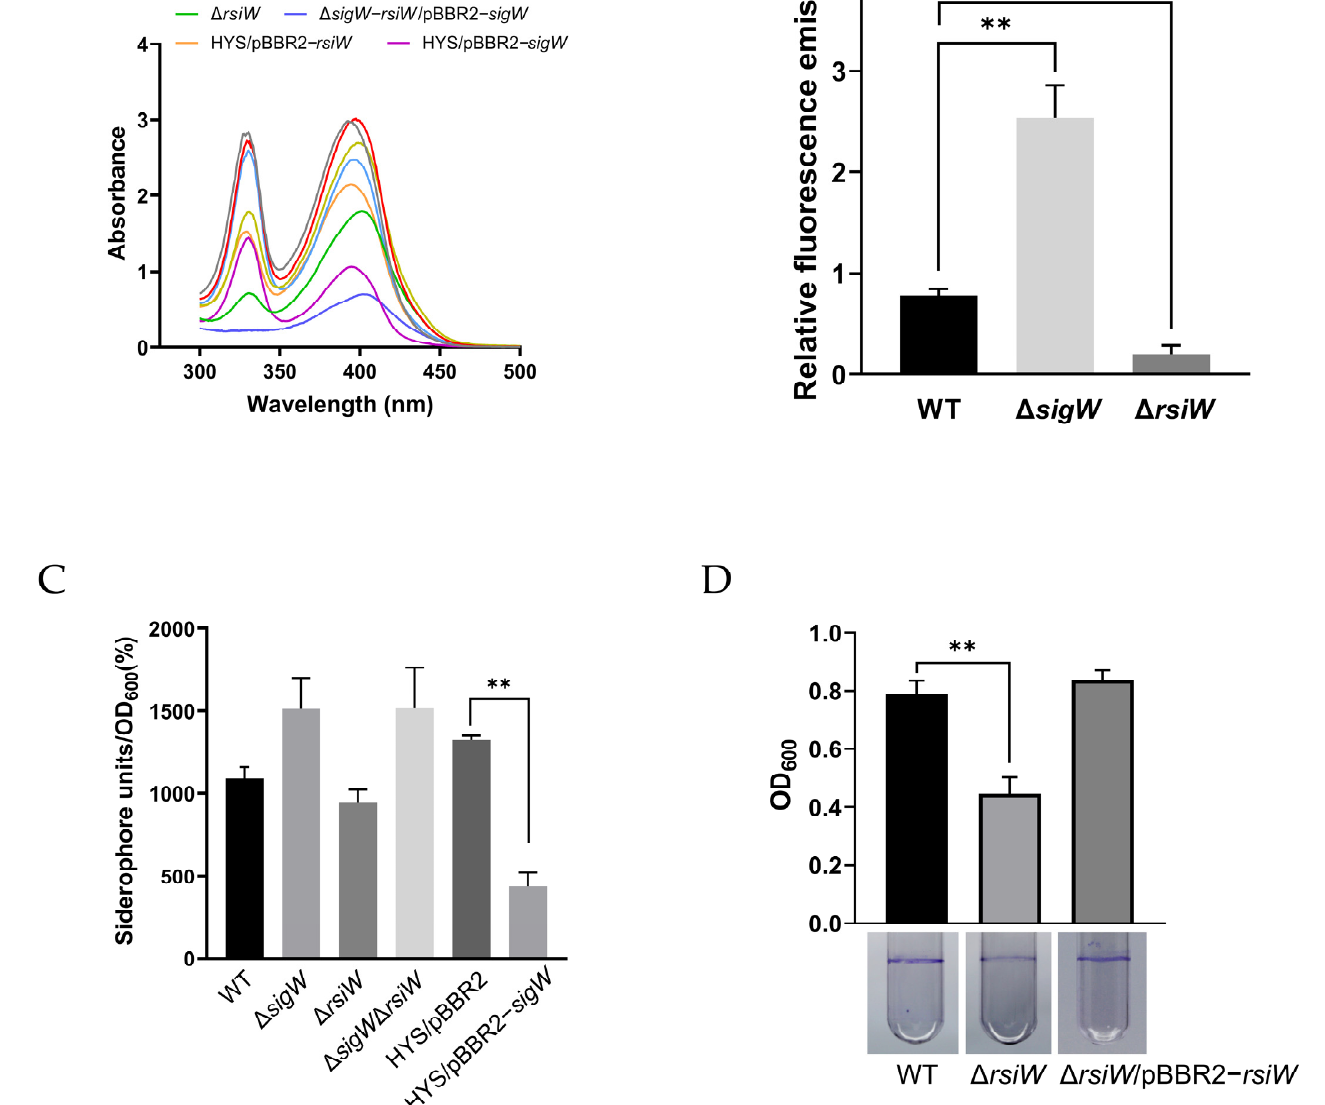
Figure 4. Effects of sigW and rsiW on siderophores and biofilm formation in P. donghuensis HYS. ( A ) Absorption spectra of the filtered supernatants of 24 h MKB cultures from wild-type HYS and the derivative strains. 7-HT has characteristic absorption at 330 and 392 nm, and pyoverdine has characteristic absorption at 405 nm. ( B ) Pyoverdine production in 24 h MKB cultures of wild-type HYS, Δ sigW , and Δ rsiW mutants. ( C ) Siderophore production in wild-type HYS and the derivative strains in liquid MKB medium was determined as siderophore units (percent) by the CAS liquid assay. ( D ) Deletion of rsiW decreased biofilm formation. The biofilm formation of wild-type HYS, Δ rsiW mutant, and the complemented strain was detected using crystal violet staining (lower) and quantified b optical density measurement (upper). The error bars indicate the mean ± SD of three independent experiments. Statistical significance was calculated using one-way ANOVA Dunnett’s multiple comparison test, * p < 0.01; ** p < 0.001.